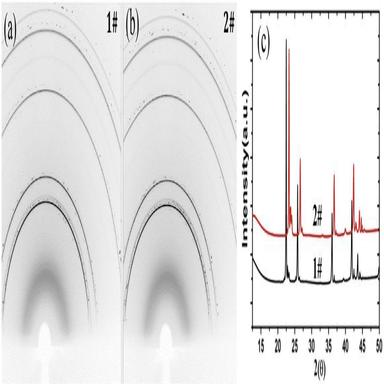
(a) Voltage variation versus time of BFO electrode. (b) Ex-situ XRD patterns for BFO electrode at different discharge-charge voltage plateau corresponding to the same location in (a).